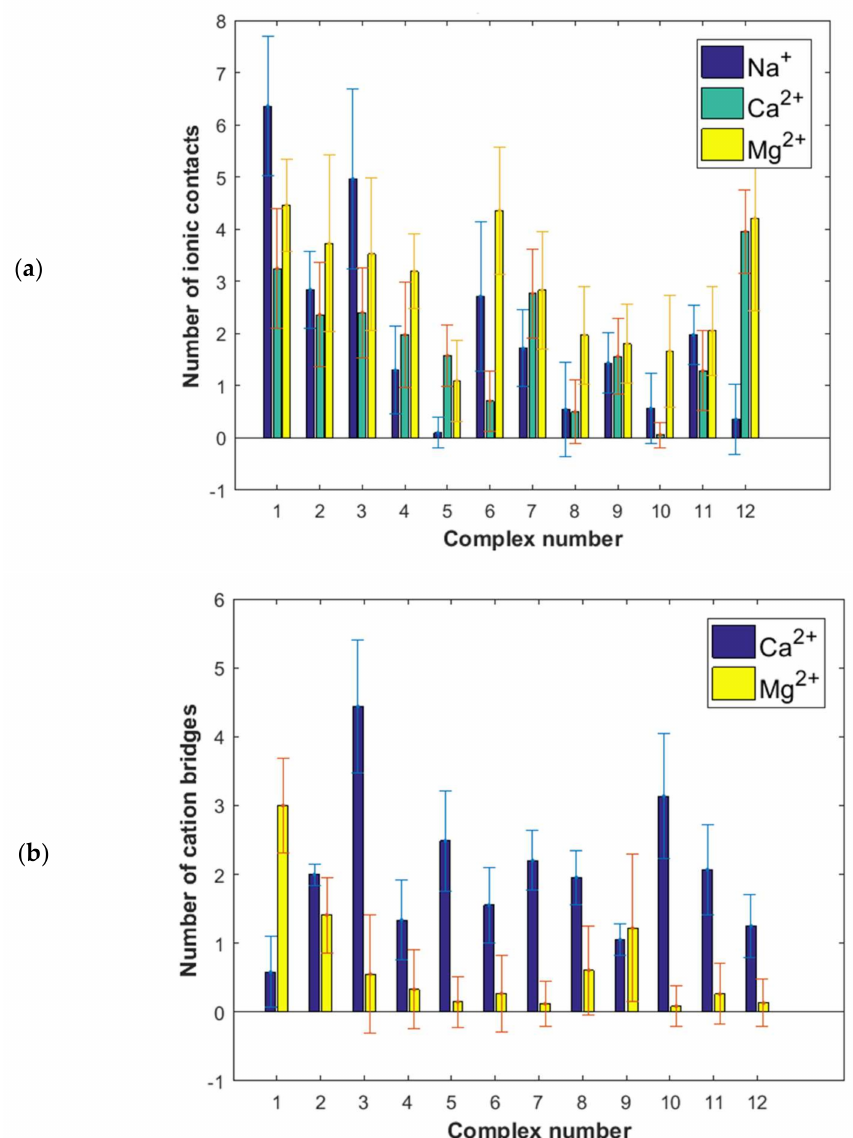
Figure 6. Number of ionic interactions between HSA and HA: ( a ) direct, ( b ) cation mediated (cation